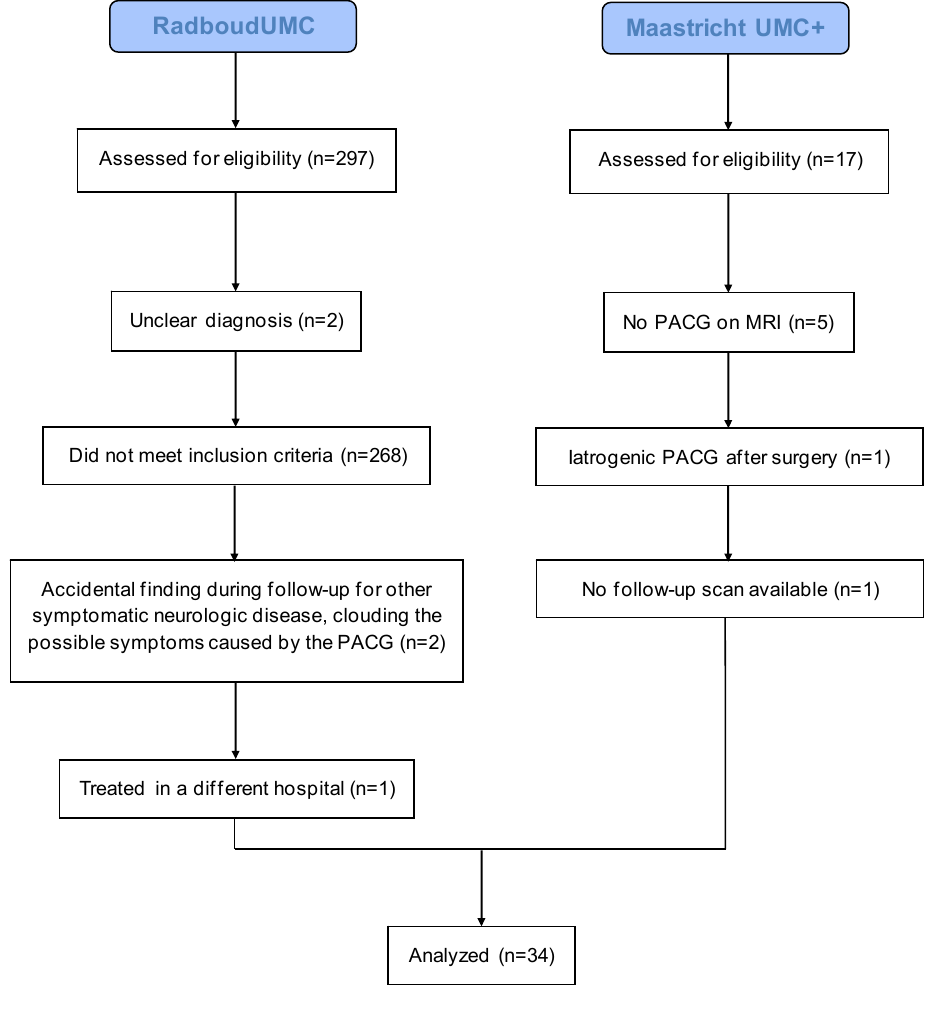
Figure 1. Flow diagram of recruited patients. Table 1. Patient characteristics in current study